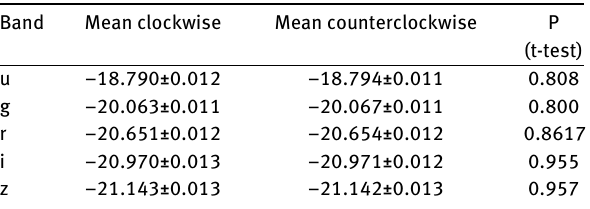
Table 12. The absolute exponential magnitude of SDSS clockwise and counter clockwise galaxies with spectra in the RA range (< 30 ∘ ∨ > 300 ∘